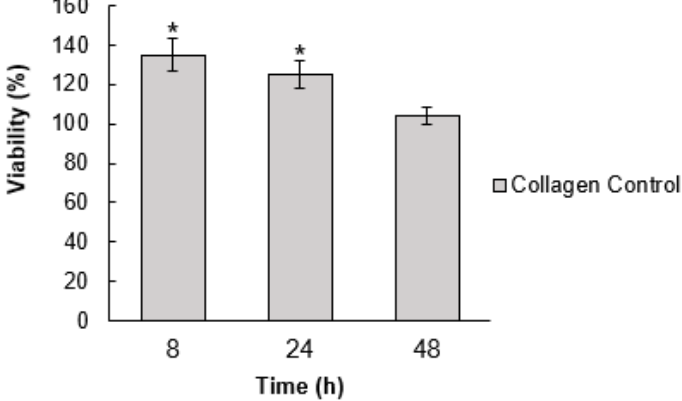
Figure 6. Cell viability of a 3T3 cell line incubated with collagen for 8, 24, and 48 h. The values were normalized with the results obtained for cells growing in culture media (mean % ± SD). Significant differences at p ≤ 0.05 are indicated by an asterisk (*). Significance was determined using an analysis of variance (ANOVA) test.